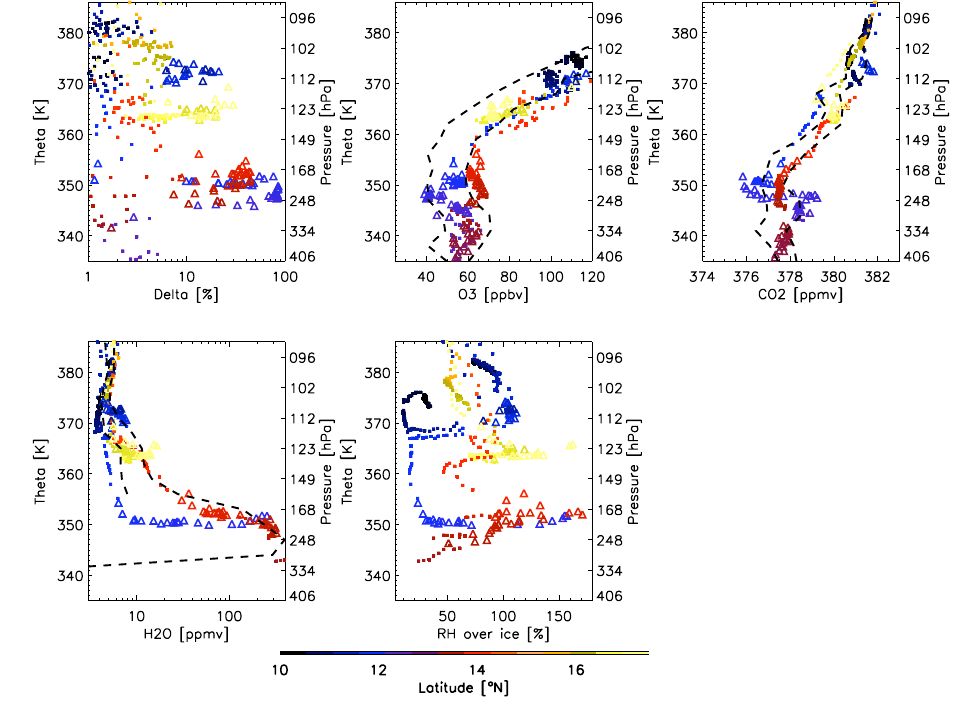
Fig. 3. As Fig. 2 but for 8 August